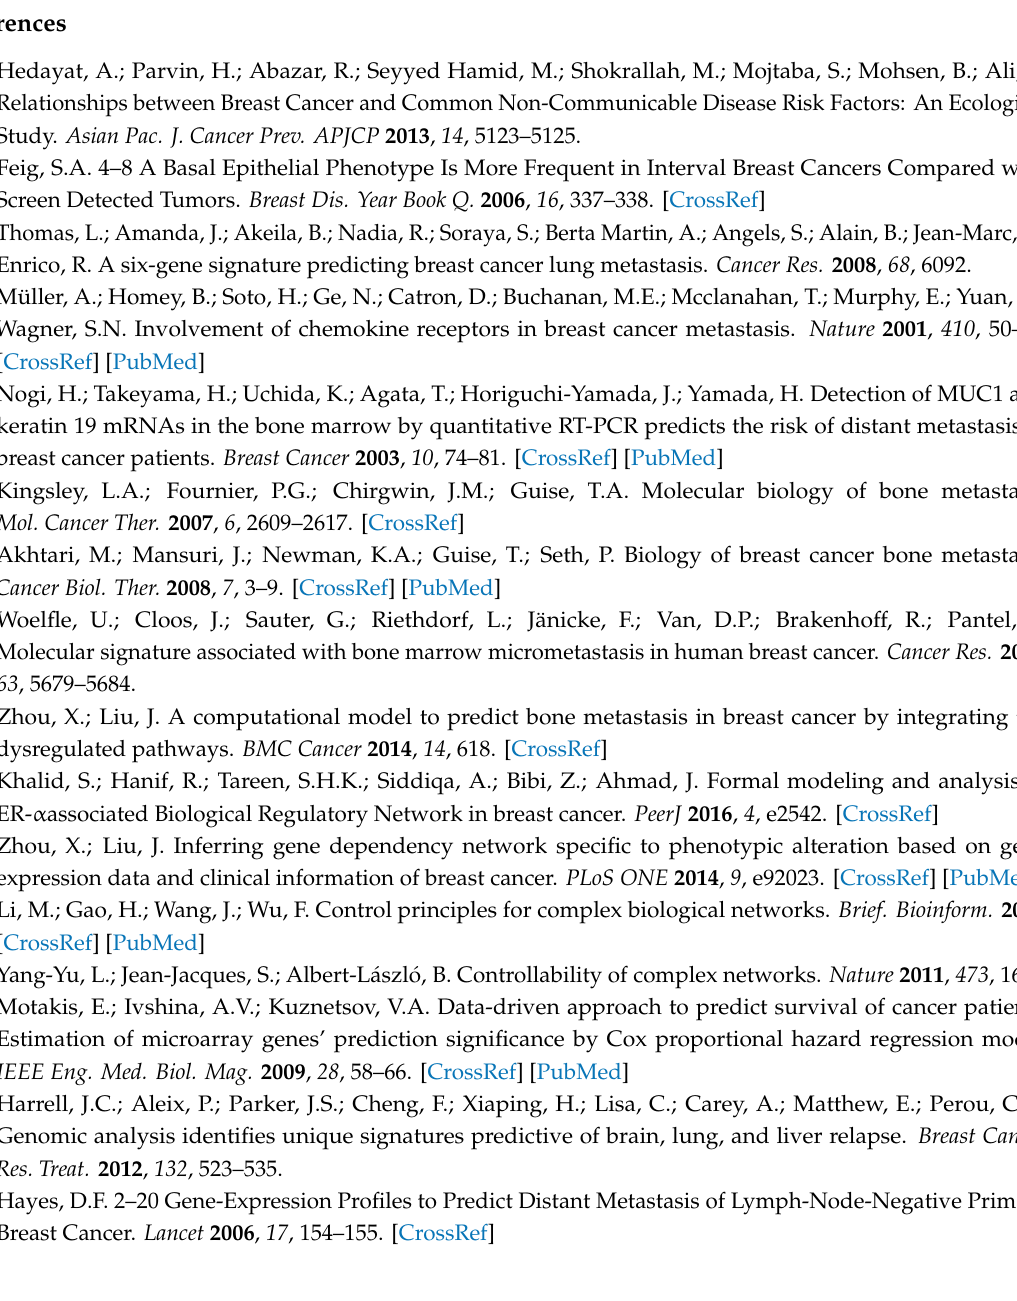
Figure S1: The gene dependency network, Table S1: The gene dependency network of bone metastasis in breast cancer, Table S2: The feature candidates, Table S3: Comparing results with other methods, Table S4: Comparing results with other